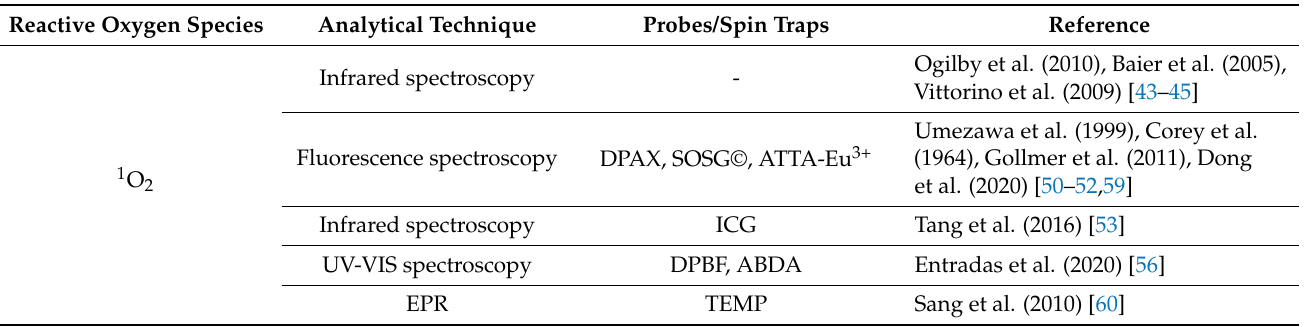
Table 1. Analytical techniques/assays to detect singlet oxygen with the corresponding probes or spin traps and relevant